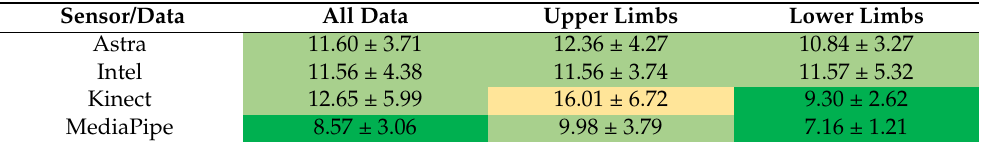
Table 4. Absolute error classification in relation to clinical error. Excellent is in dark green, good is in light green, moderate is in yellow, and poor is in red. Data are presented as means and standard deviation in degrees ( ◦ ) for all movements and splitting for upper limbs and lower limbs